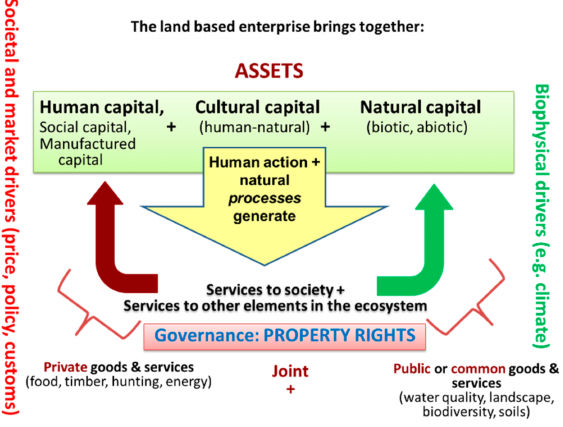
Figure 1. The provision of public goods and ecosystem services from agriculture and forestry. Source: Dwyer et al., 2016